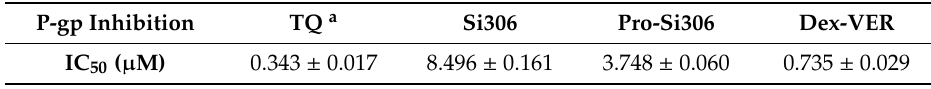
Table 2. P-gp inhibition calculated by Rho 123 accumulation in cell.